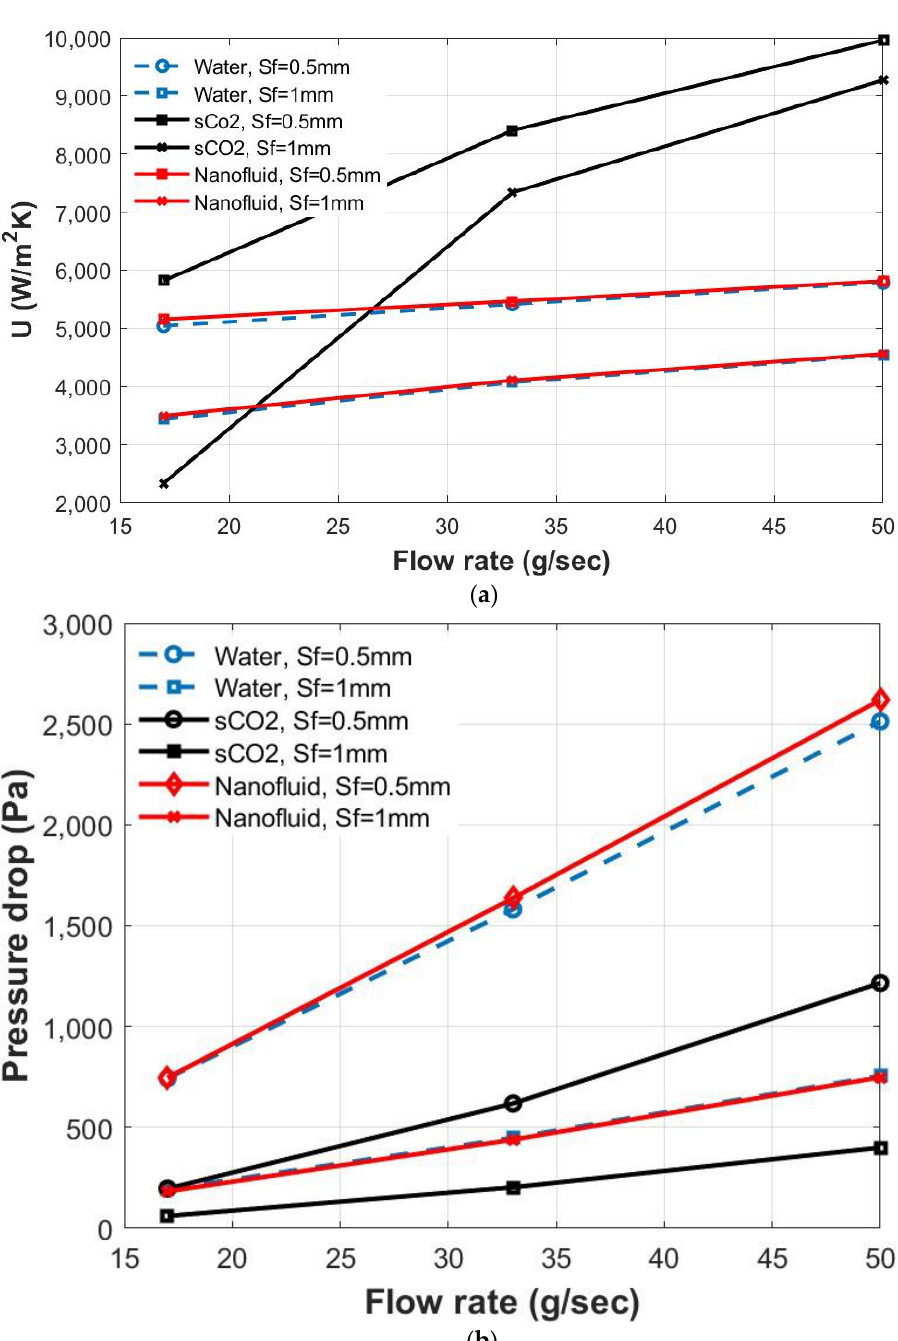
Figure 8. ( a ) The heat transfer coefficient at different flow rates corresponds to different coolants and fin spacings; ( b ) pressure drop at different flowrates corresponding to different coolants and fin spacings.